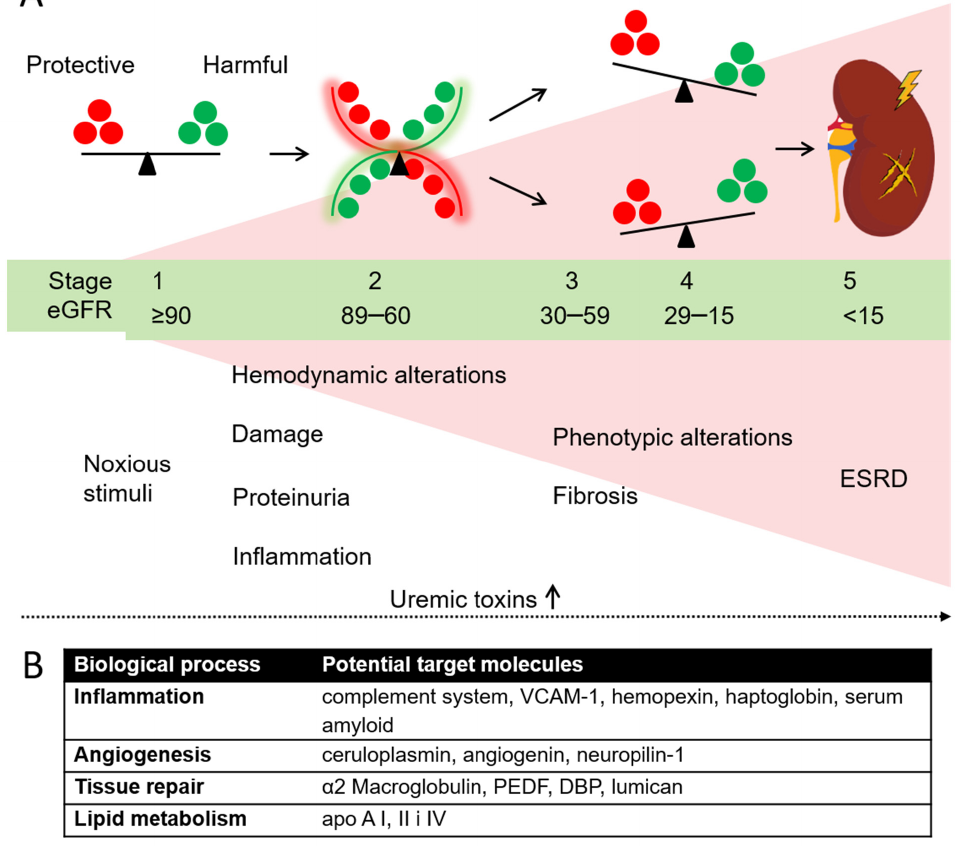
Figure 5. ( A ) Hypothetical presentation of Stage 2 CKD as a “tipping point” in further disease progression. ( B ) Proposed target proteins accompanied by a specific biological process significantly different in plasma of CKD patients stage 2 of disease as compared to the other CKD stages and healthy control group.